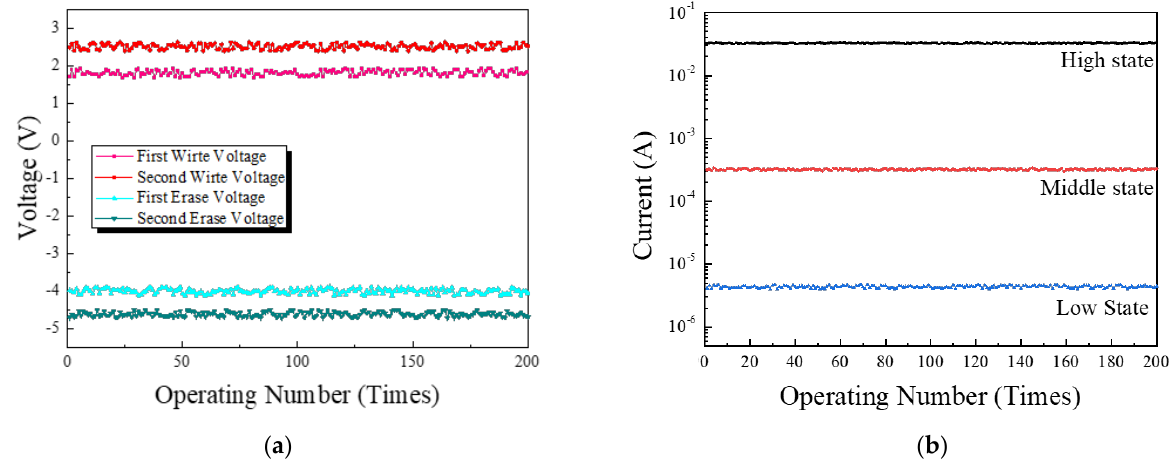
Figure 9. ( a ) Write/erase voltages, ( b ) state current of the fabricated memory device according to repeated operations.